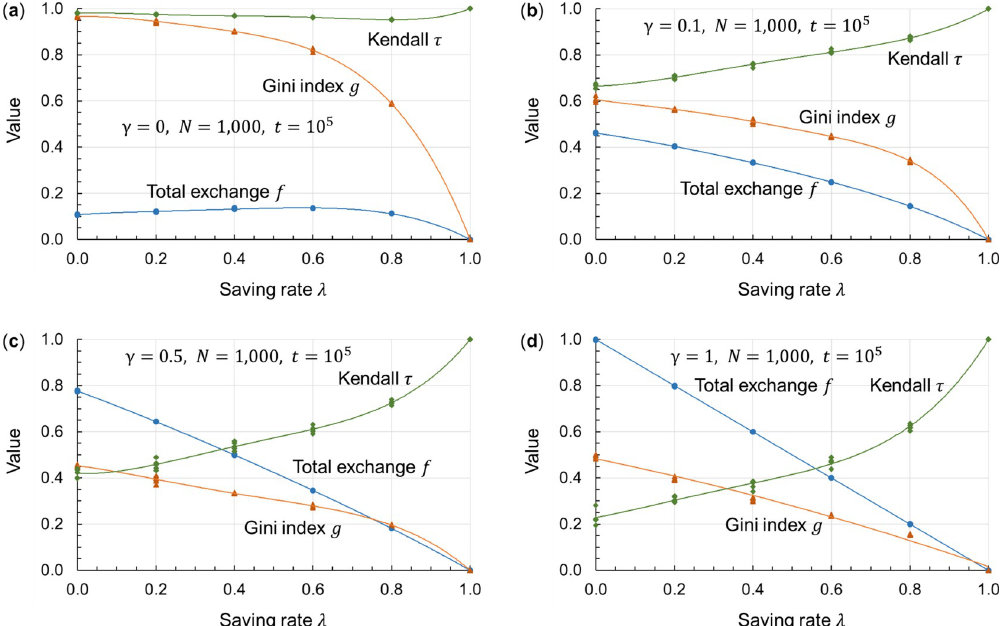
Fig 4. Simulation results of g , f , and τ for λ and γ . The horizontal axis represents the saving rate λ . In (a) to (d), the number of agents is N = 1,000, and the times are t = 10 5 , t 1 = 9.9 × 10 4 , and t 2 = 10 5 . In the vicinity of t = 10 5 , as seen in Fig 3, the max Gini index and asset distribution generally converge even as the saving rate λ differs except for the case wherein γ = 0. Under this assumption, the Gini index g , total exchange f , and Kendall rank correlation coefficient τ are simulated for the saving rate λ with respect to four different surplus contribution rates of the wealthy: γ = 0, 0.1, 0.5, 1.